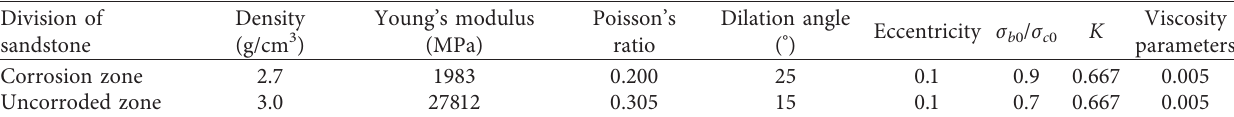
Table 1: Numerical model